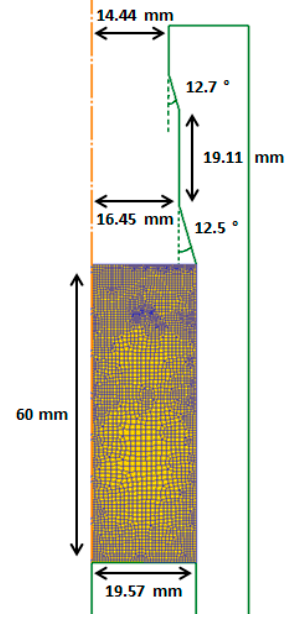
Figure 6. Mesh and geometrical details defined in [23].